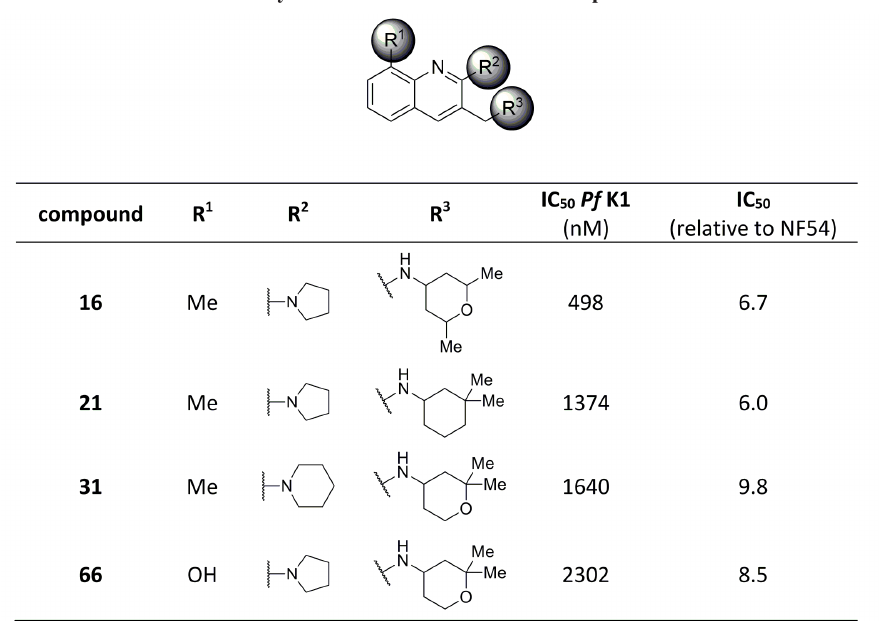
Activity on Pf K1 strain of selected